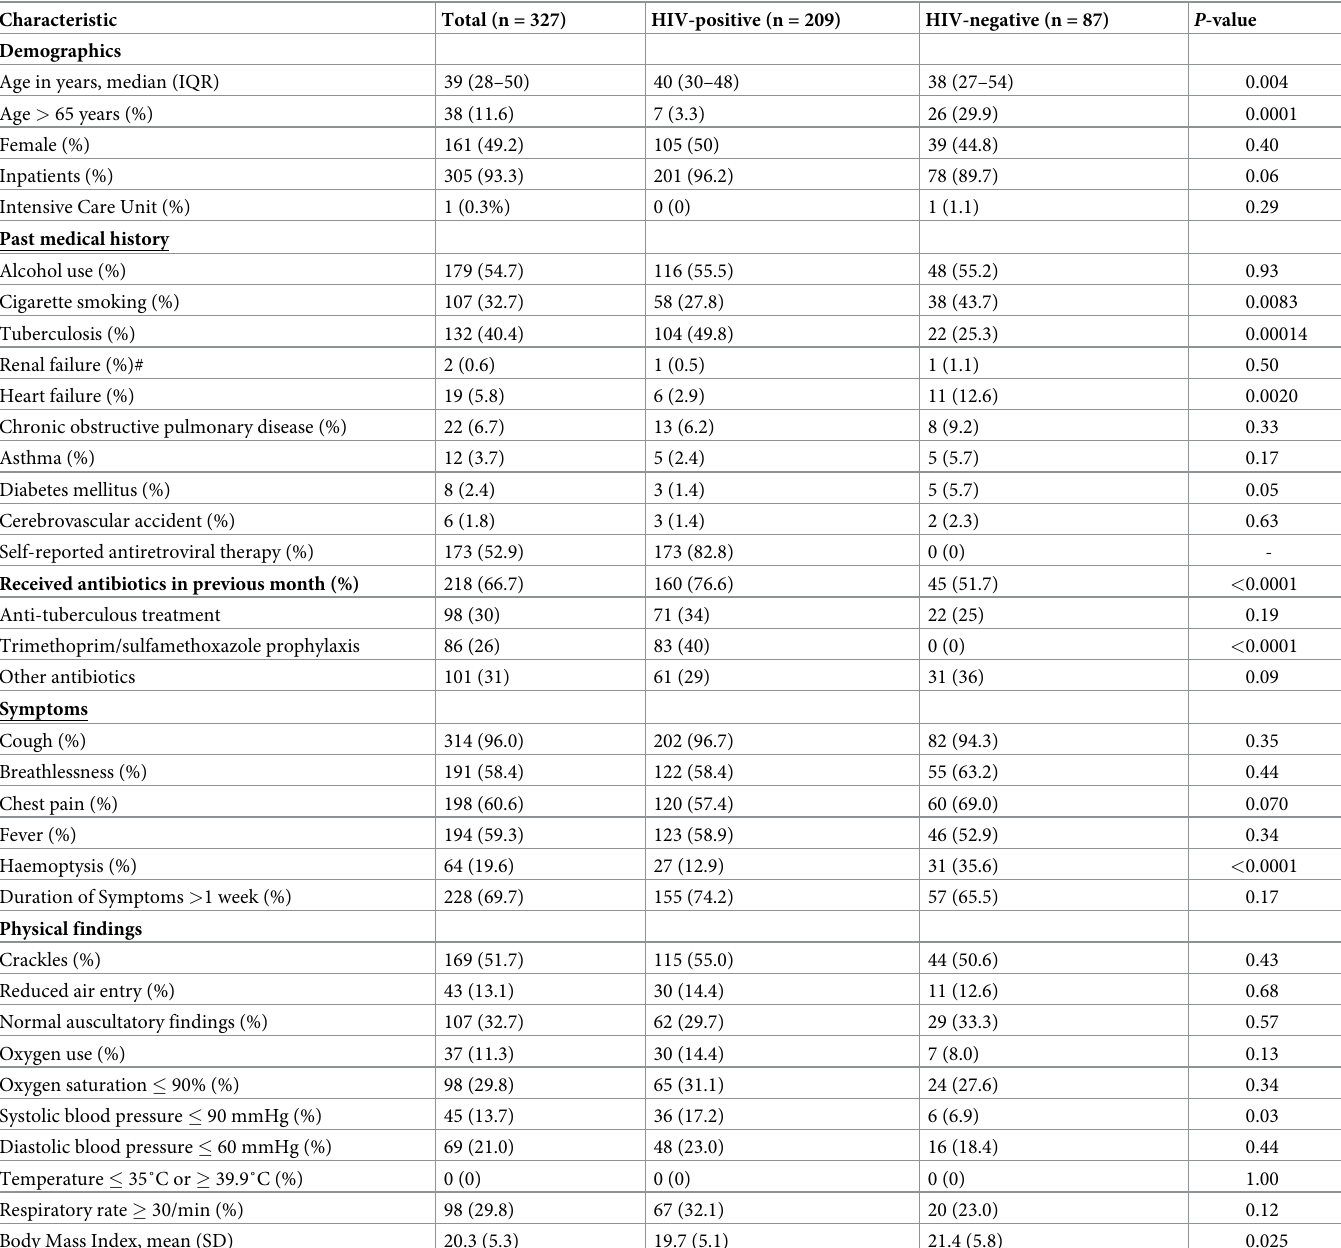
Table 1. Baseline characteristics, also noted separately for patients who were HIV infected and HIV uninfected.